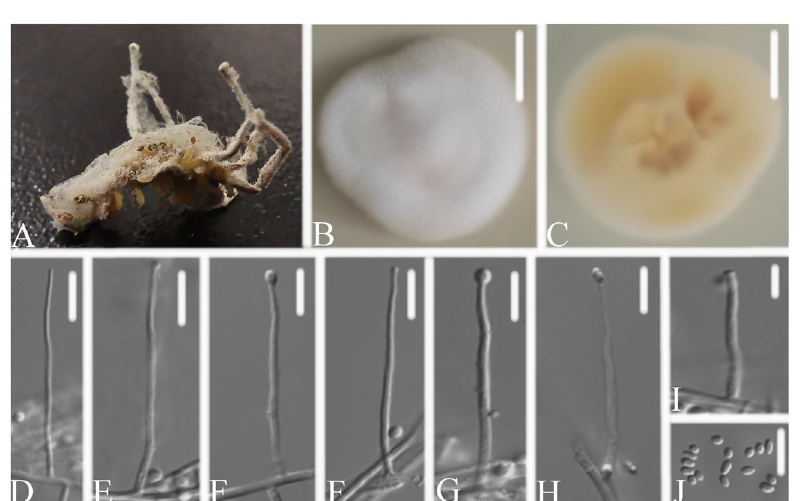
Figure 5. Simplicillium neolepidopterorum (A) infected moth (Lepidoptera) (B,C) culture plate, showing the front (B) and the reverse (C) of the colony, cultured on PDA medium (D–I) phialides solitary, conidia adhering ellipsoidal slimy head and conidia (J) conidia. Scale bars: 10 mm (B,C) , 10 μm (D–J)